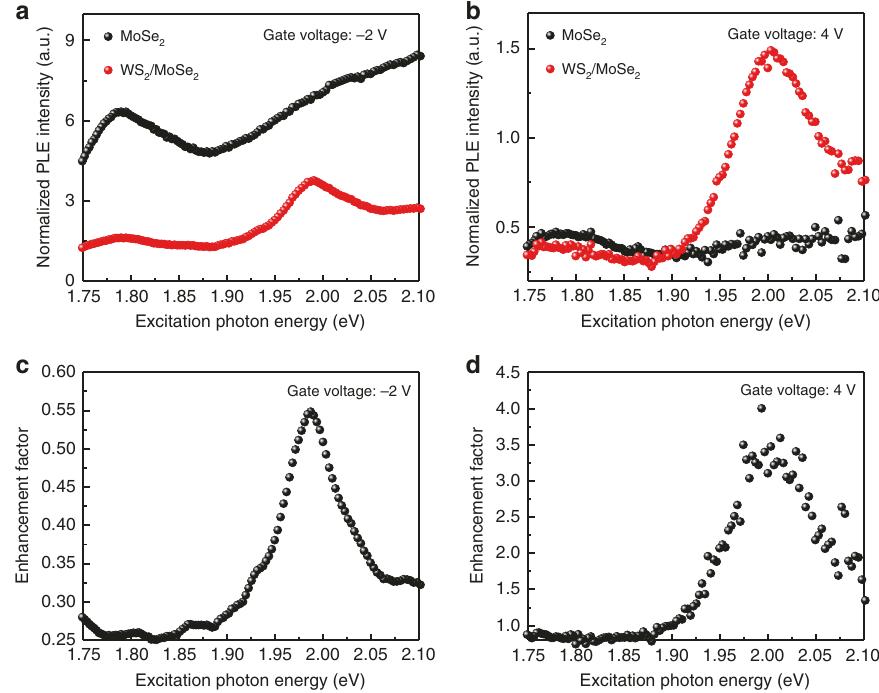
Fig. 3 PLE spectra of the monolayer MoSe 2 and MoSe 2 /WS 2 heterostructure for different gate voltages. a , b are integrated PL intensity at MoSe 2 A exciton resonance as a function of the excitation photon energy for monolayer MoSe 2 (black) and MoSe 2 /WS 2 heterojunction (red) regions at the gate voltage of − 2 V ( a ) and the gate voltage of 4 V ( b ), respectively. c , d are PL enhanced factor for the gate voltage of − 2 V ( c ) and 4 V ( d ),